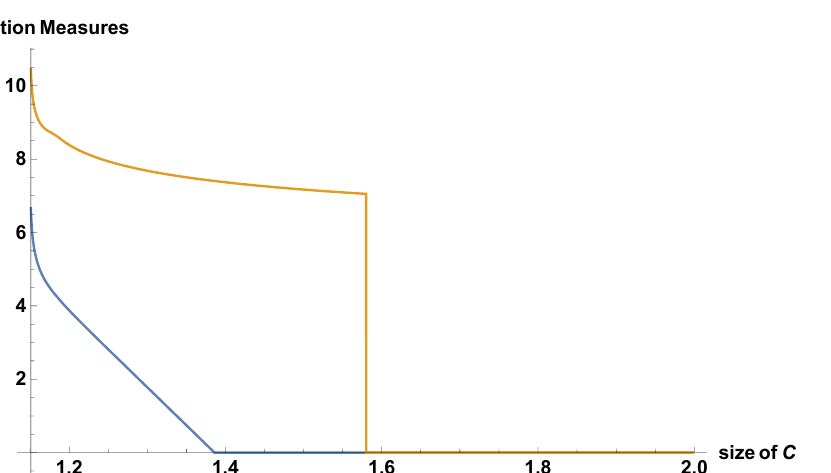
Figure 40 . Plot of correlation measures i.e. reflected entropy (yellow) and mutual information (blue) for two disjoint intervals A and B while the endpoint of the interval C = [ r 1 ,r ] is increased by shifting the point r in the bath BCFT 2 s. In the y-axis, the correlation measures are plotted after scaling over the central charge c of the BCFT 2 s. Here r I = 1 , r O = 2 , (cid:15) = . 001 , β = . 1 , c = 500 , t = . 15 , r 1 = 1 . 15 , S bdyb = 875 and S bdya = 850 .